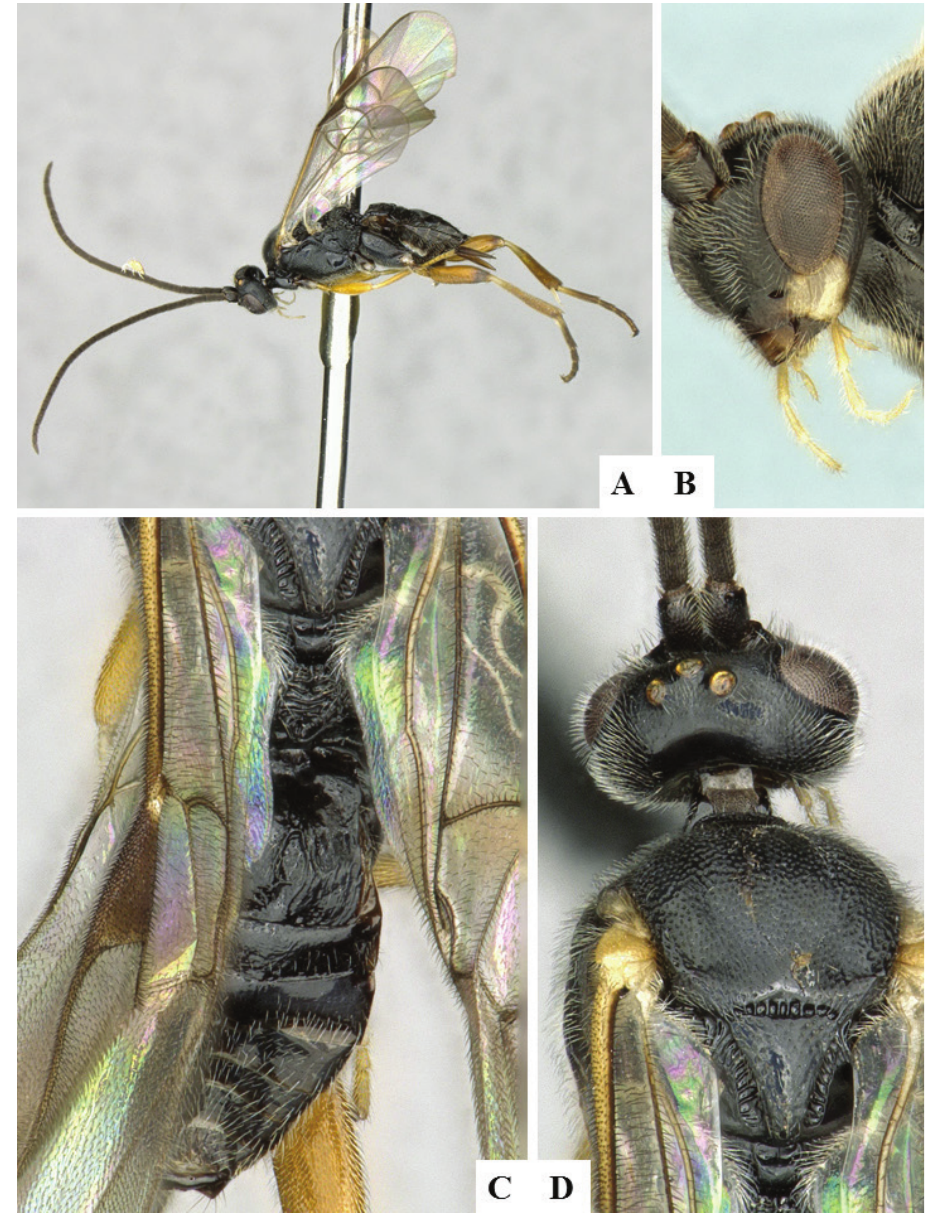
Figure 5. Alphomelon winniewertzae . A- Habitus, lateral B Head, lateral C Metasoma, dorsal D Head and mesosoma (partially),